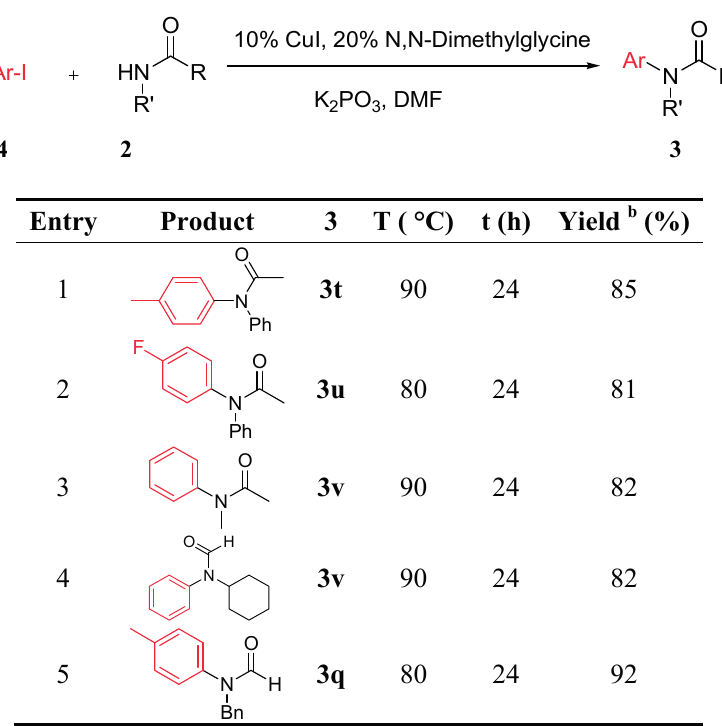
Table 3. CuI/ N,N -dimethylglycine catalyzed the coupling between hindered, unreactive amides and aryl iodides a